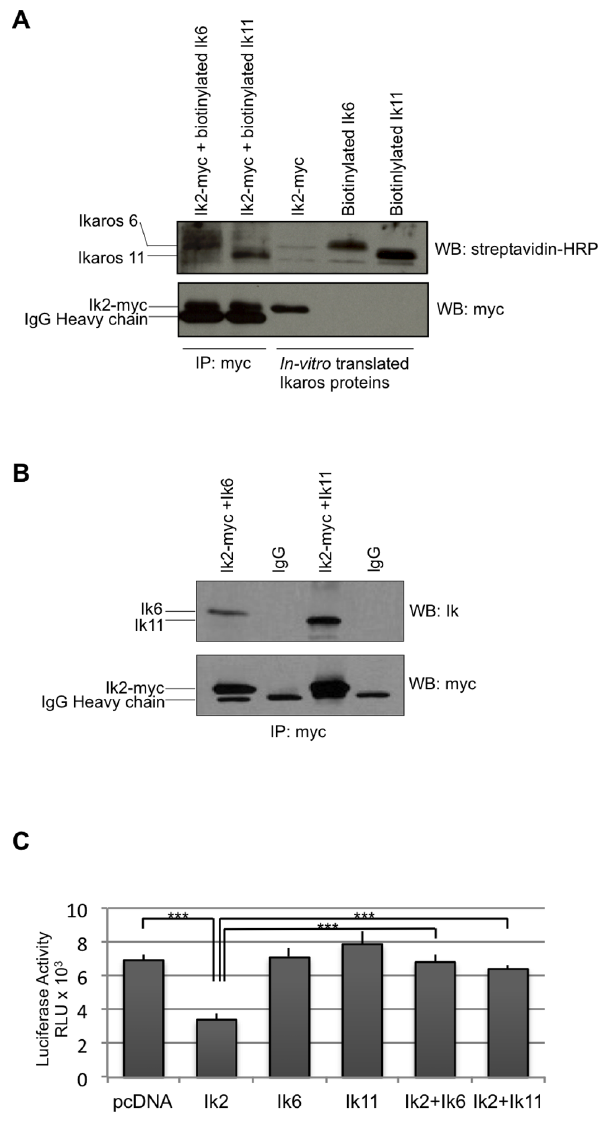
Figure 3. Ik11 acts as a dominant negative isoform. ( A ) In vitro co-immunoprecipitation of Ik2 with the short isoforms Ik11 or Ik6. Ik2- myc, biotinylated-Ik11 and biotinylated-Ik6 were generated by in vitro transcription/translation. After 1 h incubation of Ik2-Myc with Ik11 or Ik6, the Ik2 complexes were immunoprecipitated with an anti-Myc antibody and subjected to Western blot analysis as indicated (lanes 1 and 2). Lanes 3, 4 and 5 contained the three in vitro translated proteins without immunoprecipitation. ( B ) In vivo heterodimerization of Ik2 with the splice variants Ik11 or Ik6. The 293T HEK cell line was co-transfected with pcDNA3.1/Myc-HysB-Ik2 along with pcDNA3.1-Ik6 or pcDNA3.1- Ik11. The Ik2 immunoprecipitation was performed with an anti-Myc antibody and the immune-complexes were analyzed by Western blotting as indicated. ( C ) Luciferase assay showing functional domi- nant-negative activity of Ik11. The 293T HEK cell line was co-transfected with pcDNA3.1-Ik2, pcDNA3.1-Ik6 or pcDNA3.1-Ik11 or their combina- tions along with a reporter-LUC construct driven by a promoter containing Ikaros-binding sites. Mean 6 SD of triplicate wells is shown (*** p , 0.001). Data shown are representative of three different experiments. isolation kits (Miltenyi Biotec) were used to purify monocytes, B and T cells, respectively.